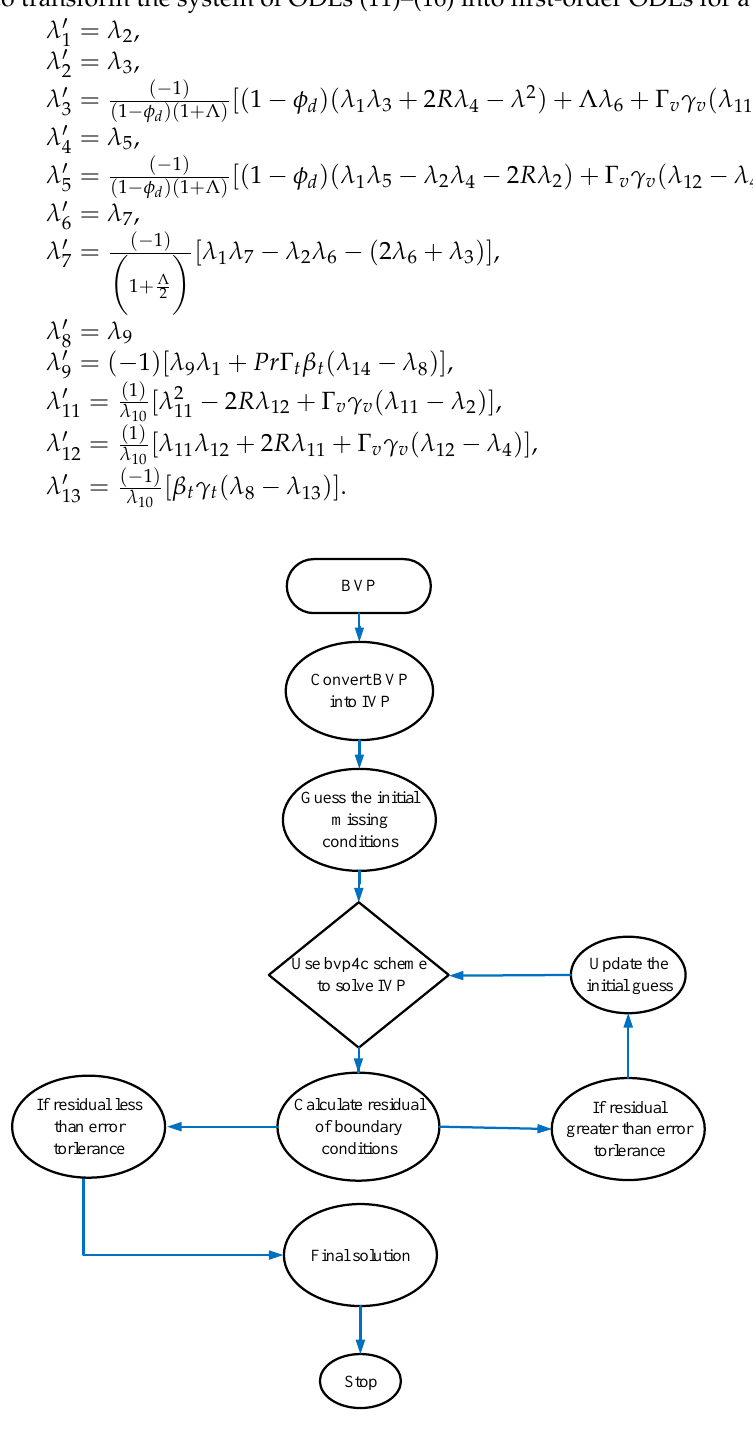
Figure 2. Numerical solution flow